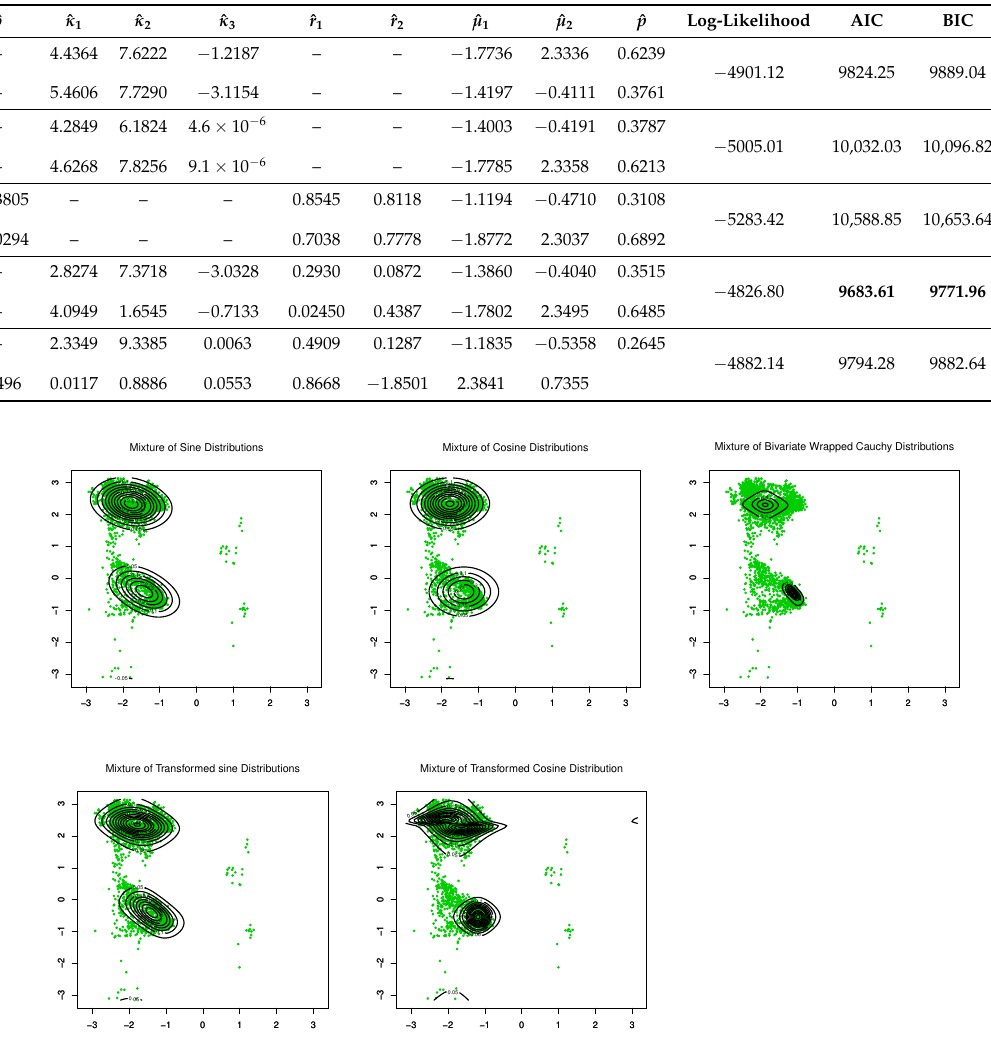
Figure 11. Contour plots of fitted pdfs together with scatter plots for TCBIG.VAL.right ( n = 2673). The last row includes the proposed models.